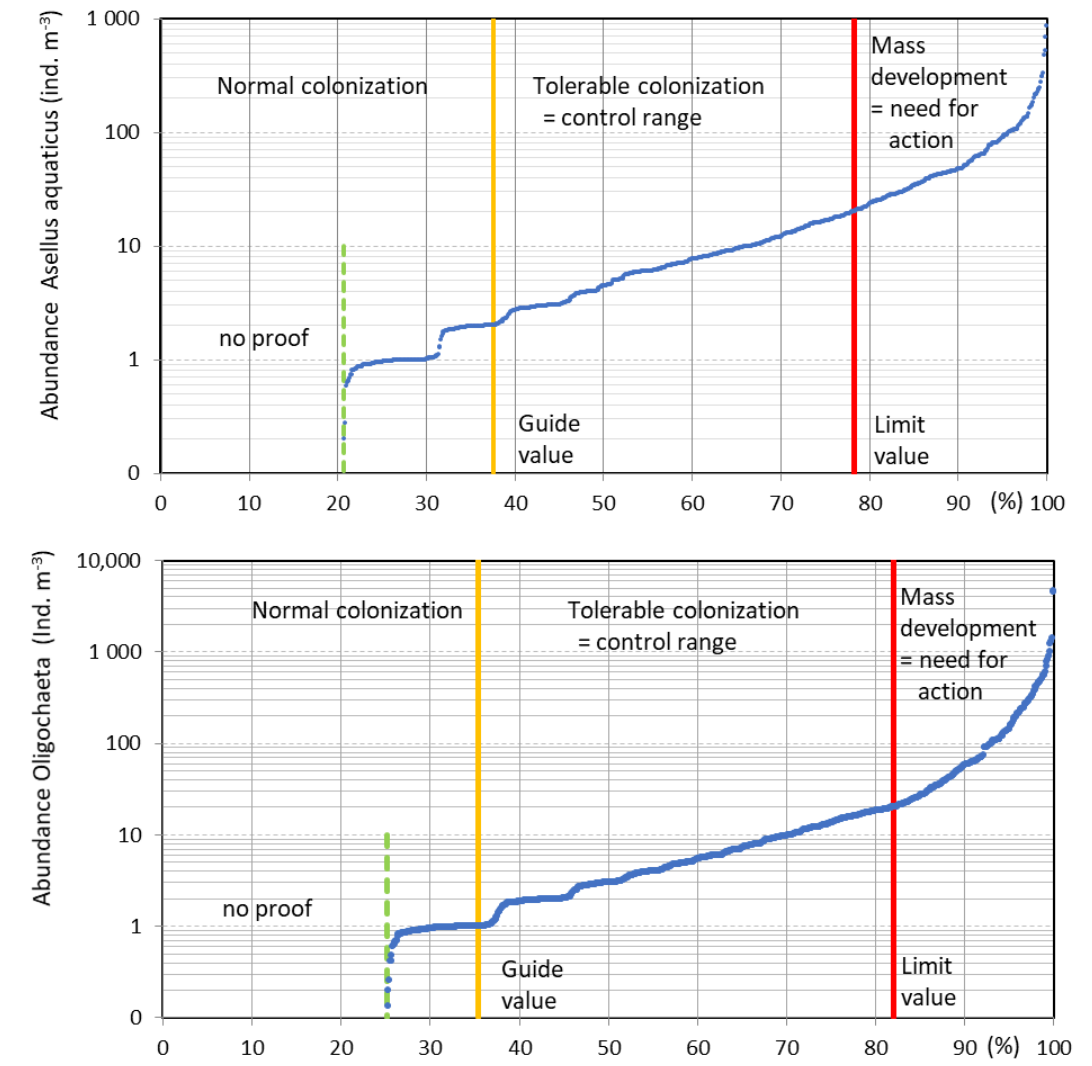
Figure 3. Overview of operation modes for innovative CHP solutions (figure adjusted from [ ? ]). Figure 4. Abundance of water lice ( above ) and aquatic oligochaetes ( below ) in drinking water networks. Data base = 1039 hydrant samples; classification was done with three empirical load classes (see